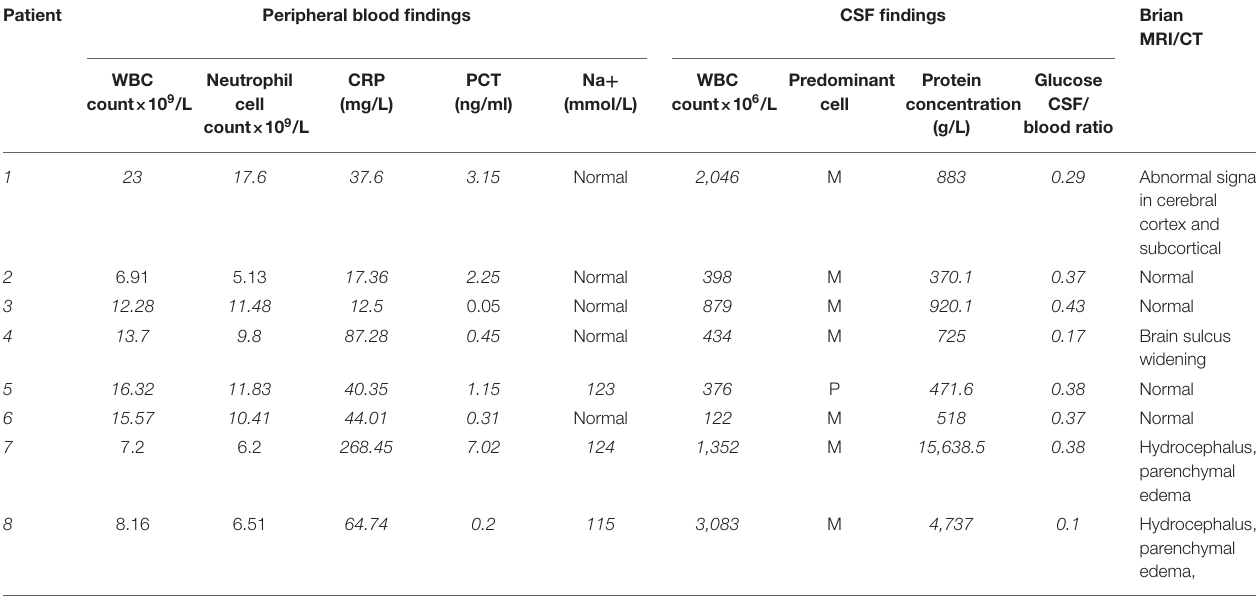
TABLE 2 | Laboratory examinations and brain imaging in the patients. Patient Peripheral blood findings CSF findings Brian